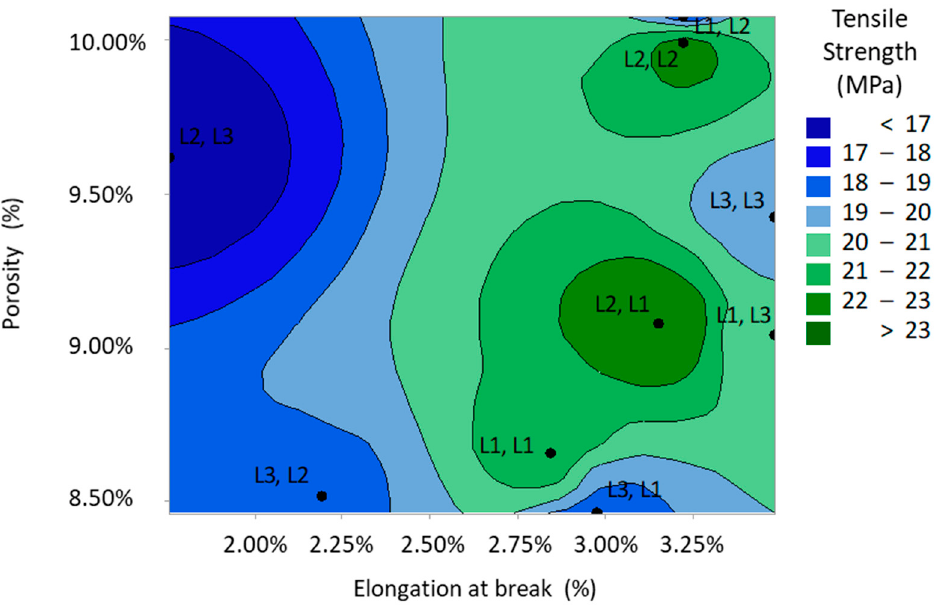
Figure 12. Contour plot of tensile strength (MPa) versus porosity (%) and elongation at break (%).